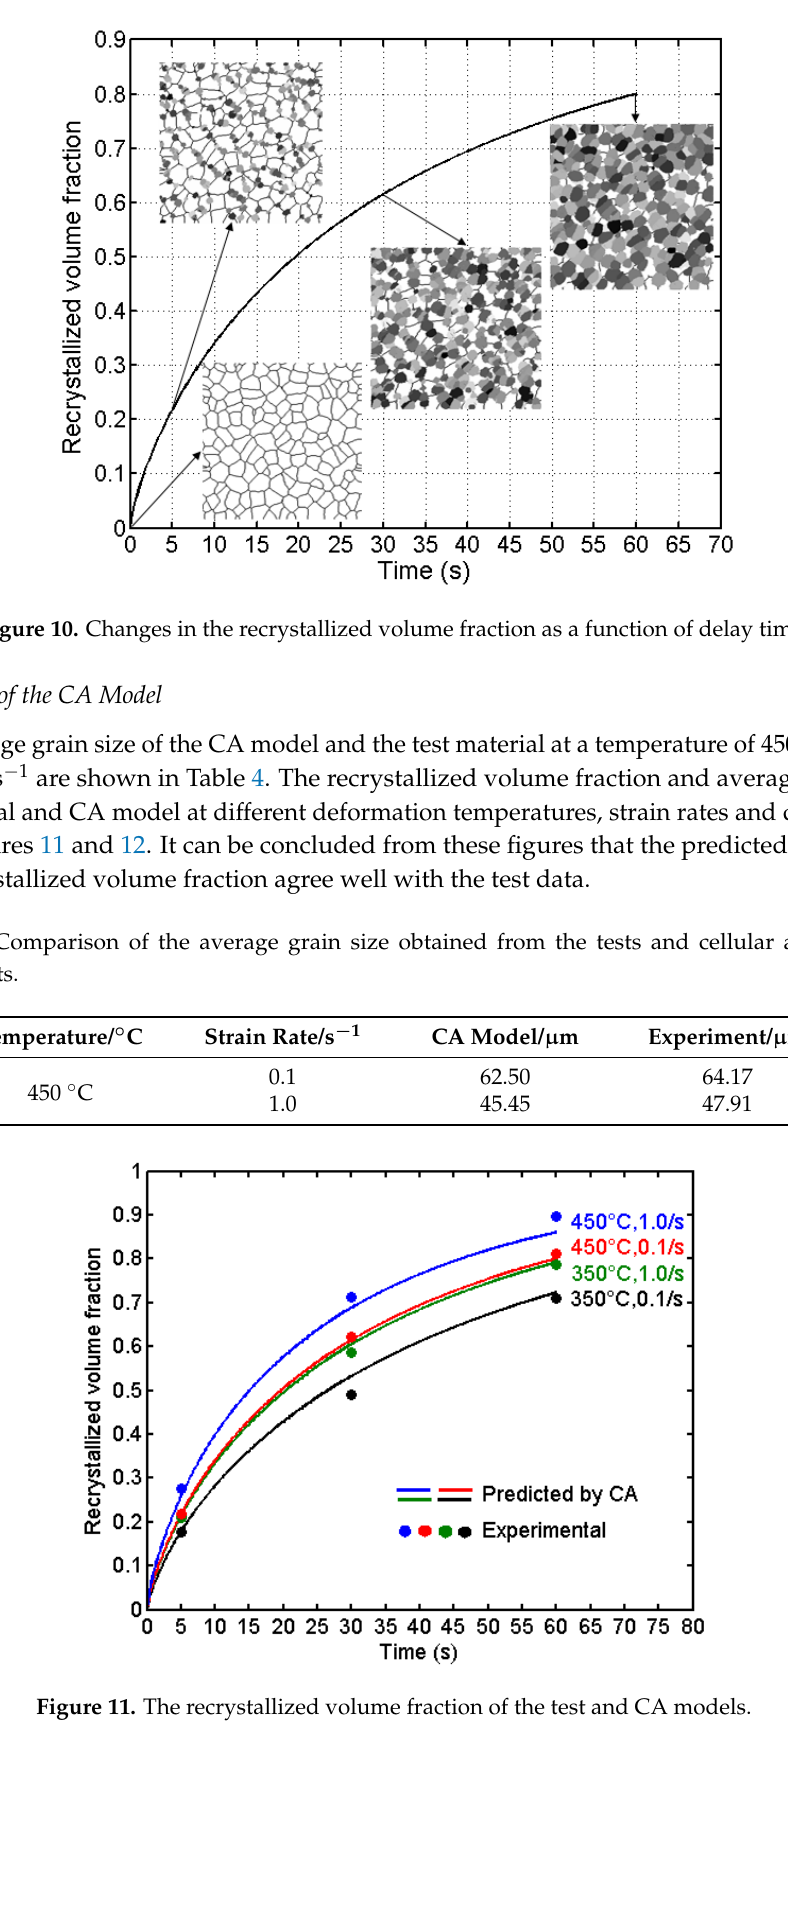
Figure 11. The recrystallized volume fraction of the test and CA models.